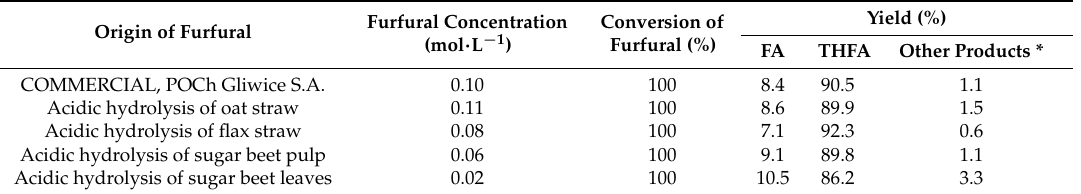
Table 4. Catalytic properties of (10) W x C- β -SiC catalysts after 2 h of bio-furfural reduction. The results in the table are expressed as the arithmetic mean of a minimum of three